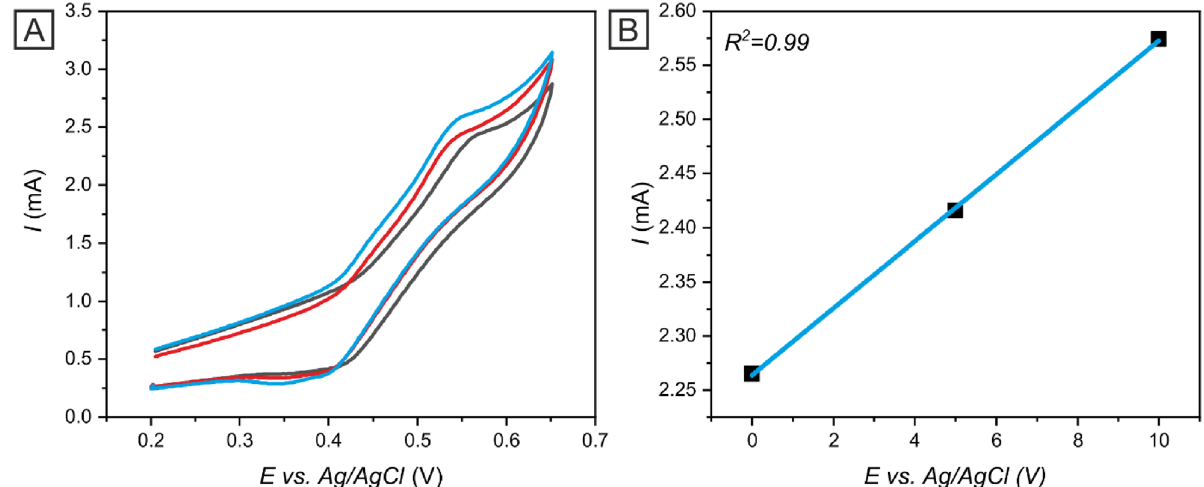
Figure 11. Cyclic voltammograms of pure blood serum (black line) and blood serum samples containing 2 × 10 –6 mol dm −3 (red line) and 5 × 10 –6 mol dm −3 (blue line) insulin on Ni-c-ITO at 50 mV s −1 ( A ). The dependency of the peak current on the insulin concentration fitted by a linear function ( B